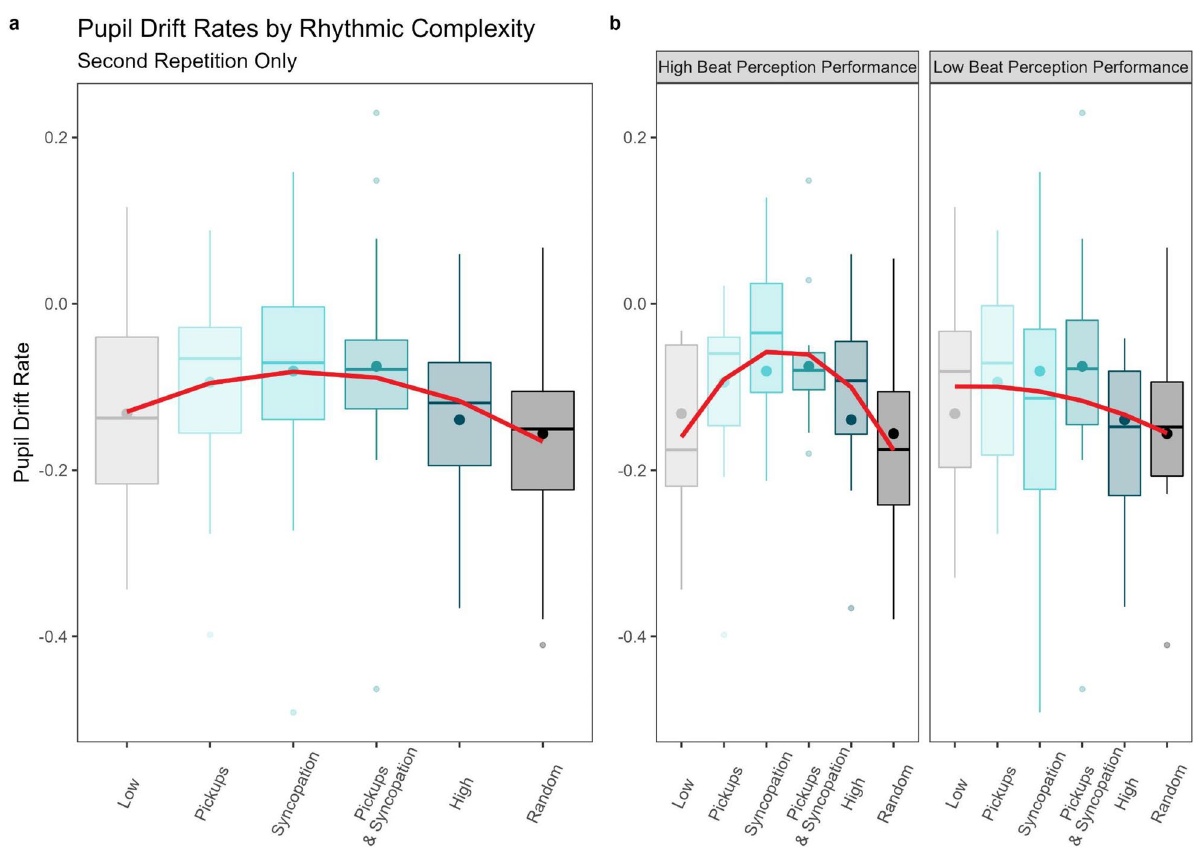
Figure 6. Quadratic fits for the pupil drift rate across rhythmic complexity for Repetition 2 where the significant interaction was found. ( A ) Quadratic predictor of pupil drift rates by rhythm condition during the second repetition of the drum pattern within the trials. Large dots represent averages. ( B ) Pupil drift rates with quadratic predictors by high and low beat perception performance. High performers displayed a significant quadratic relationship with rhythmic complexity while low performers did